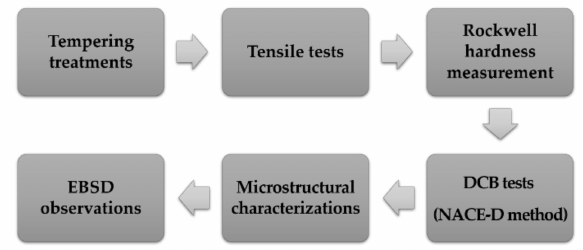
Figure 2. A flow chart of the experimental